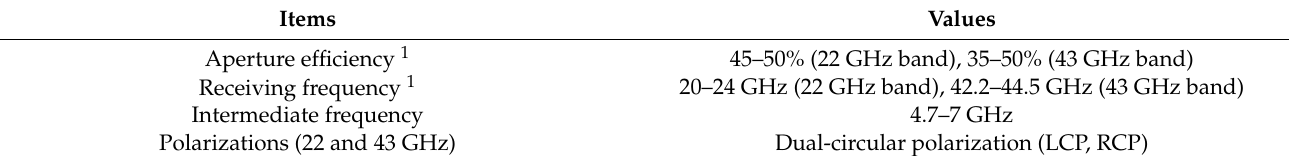
Table 1. Specifications of VERA 20 m telescopes.